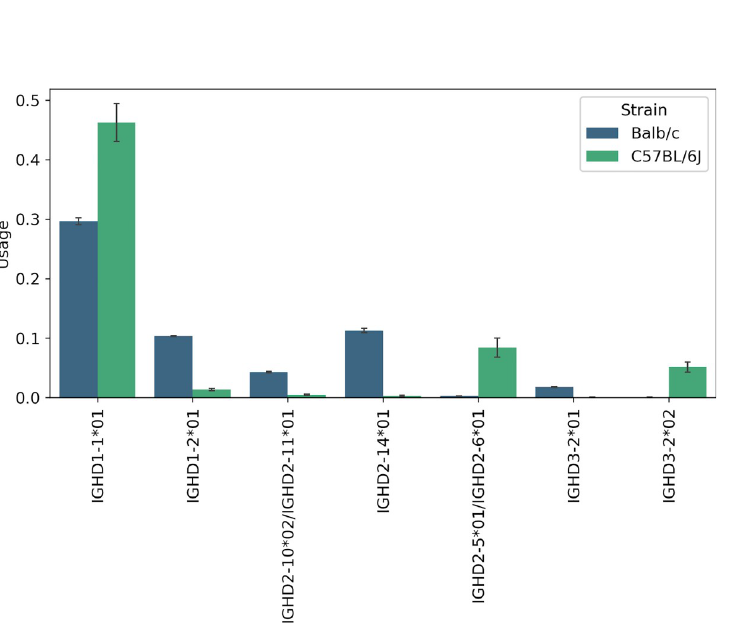
Fig 15. Genes with differential usage in Balb/c and C57BL/6J strains. Except IGHD1-1 � 01, all genes were inferred only in one strain.